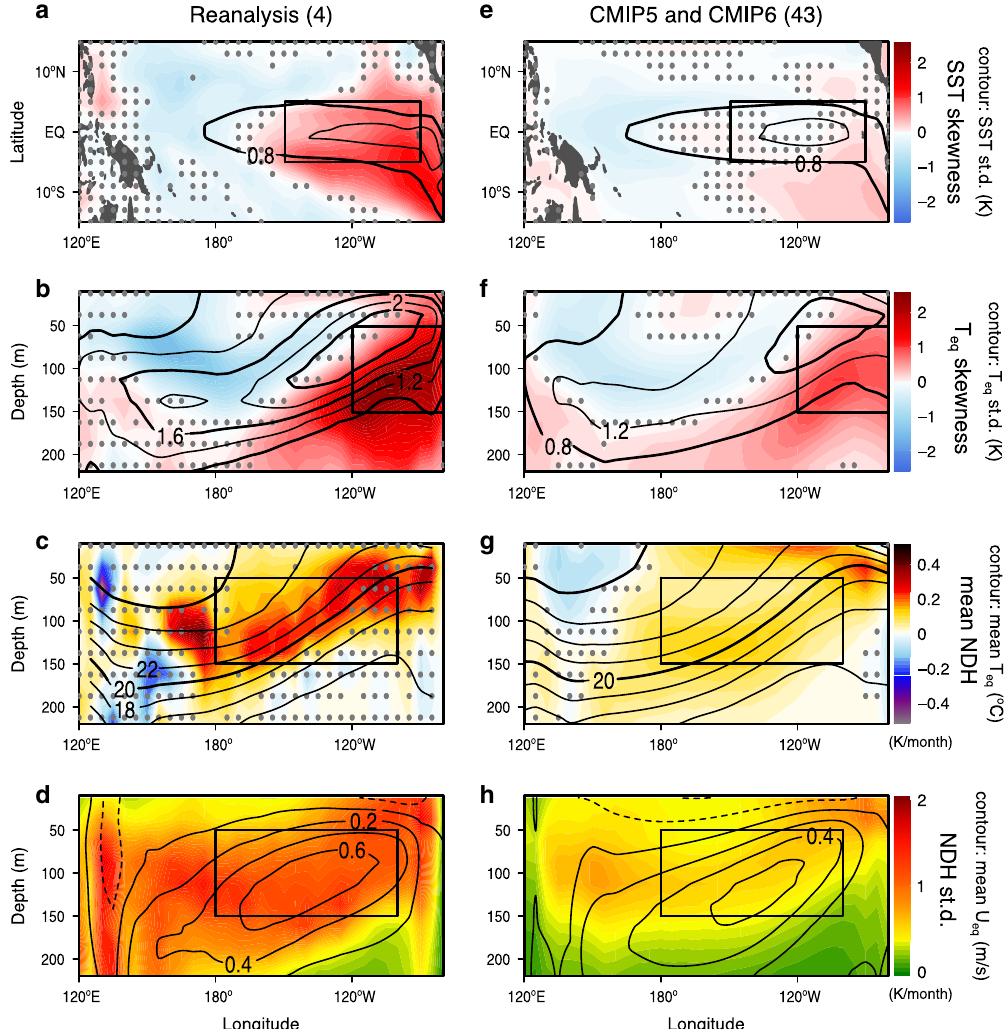
Fig. 1 Nonlinearity in the equatorial Paci fi c Ocean. a Horizontal map of the skewness γ (shading) and standard deviation σ (contours, K) of the sea surface temperature (SST) anomaly. b Equatorial cross section of γ (shading) and σ (contours, K) of the potential temperature anomaly. c The long-term mean of nonlinear dynamical heating (NDH) (shading, K month − 1 ) and potential temperature (contours, °C). d σ of the NDH (shading, K month − 1 ) and the long- term mean of the zonal ocean current (contours, m s − 1 ). Four reanalysis datasets are used in ( a – d ). Dots in a – c indicate the shading values that are not statistically signi fi cant at the 95% con fi dence level. Boxes represent the Niño-3 region in ( a ) while the averaging regions for the mean and σ of NDH in ( c , d ) and the skewness of subsurface temperature in ( b ). e – h Same as in ( a – d ), except for the historical simulations of 43